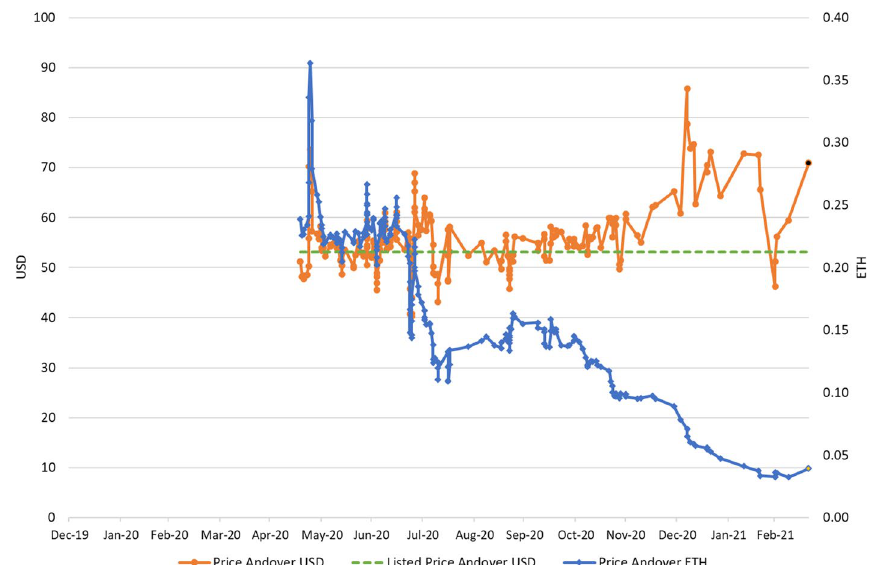
Fig. 18 Price (in USD and ETH) of 25,097 Andover Drive Dearborn Hights MI. Each dot represents one transaction. Last colored dot is ask price on Uniswap